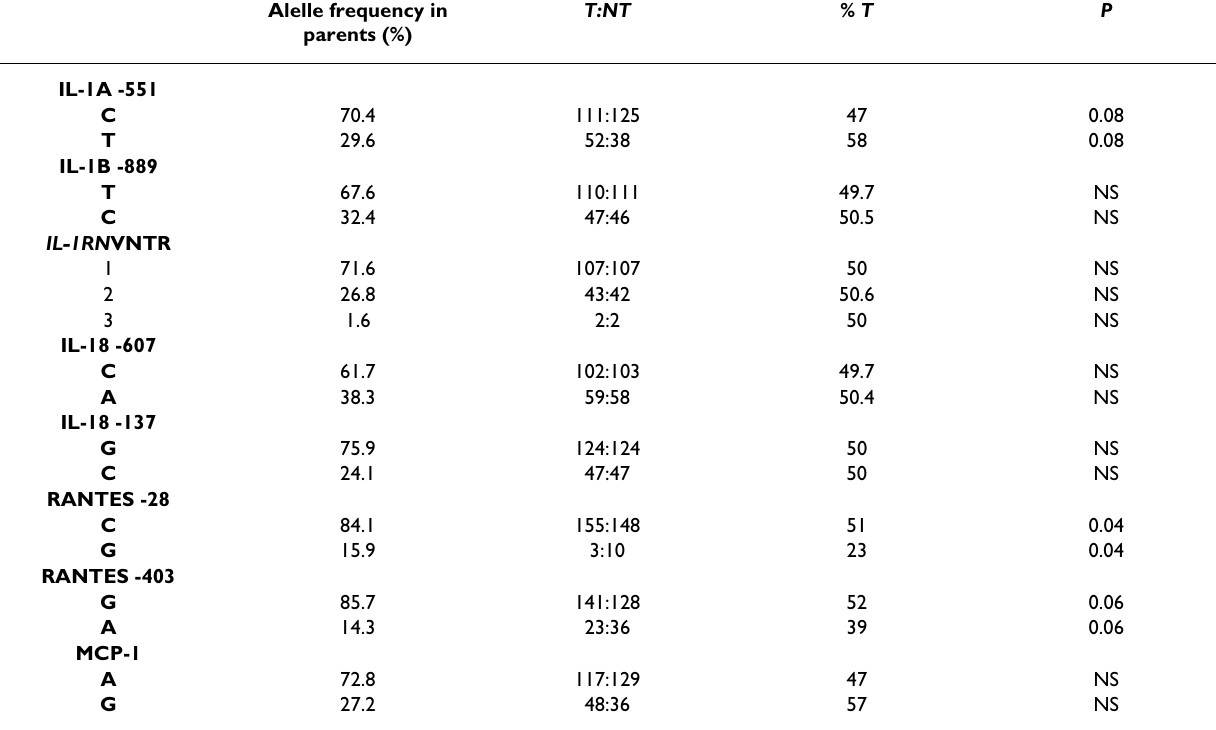
Table 2: Allelic frequencies and percentage of transmission of IL-1 α , IL-1 β , IL-1RN, IL-18, RANTES and MCP-1 genetic variants in CD families. Alelle frequency in parents